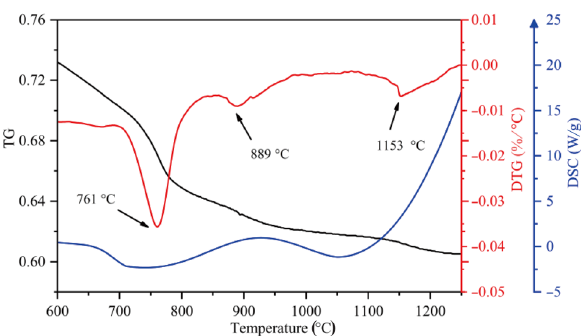
Fig. 2 TG–DSC patterns of La(CoCrFeMnNiAl 0.5 ) 1/5.5 O 3 − δ .